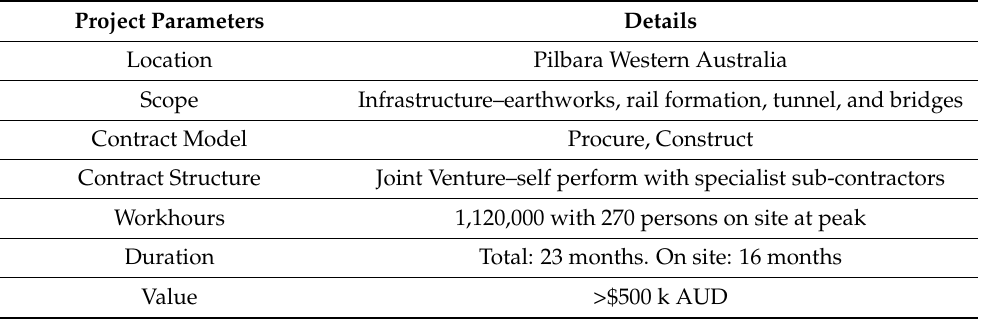
Table 1. Project